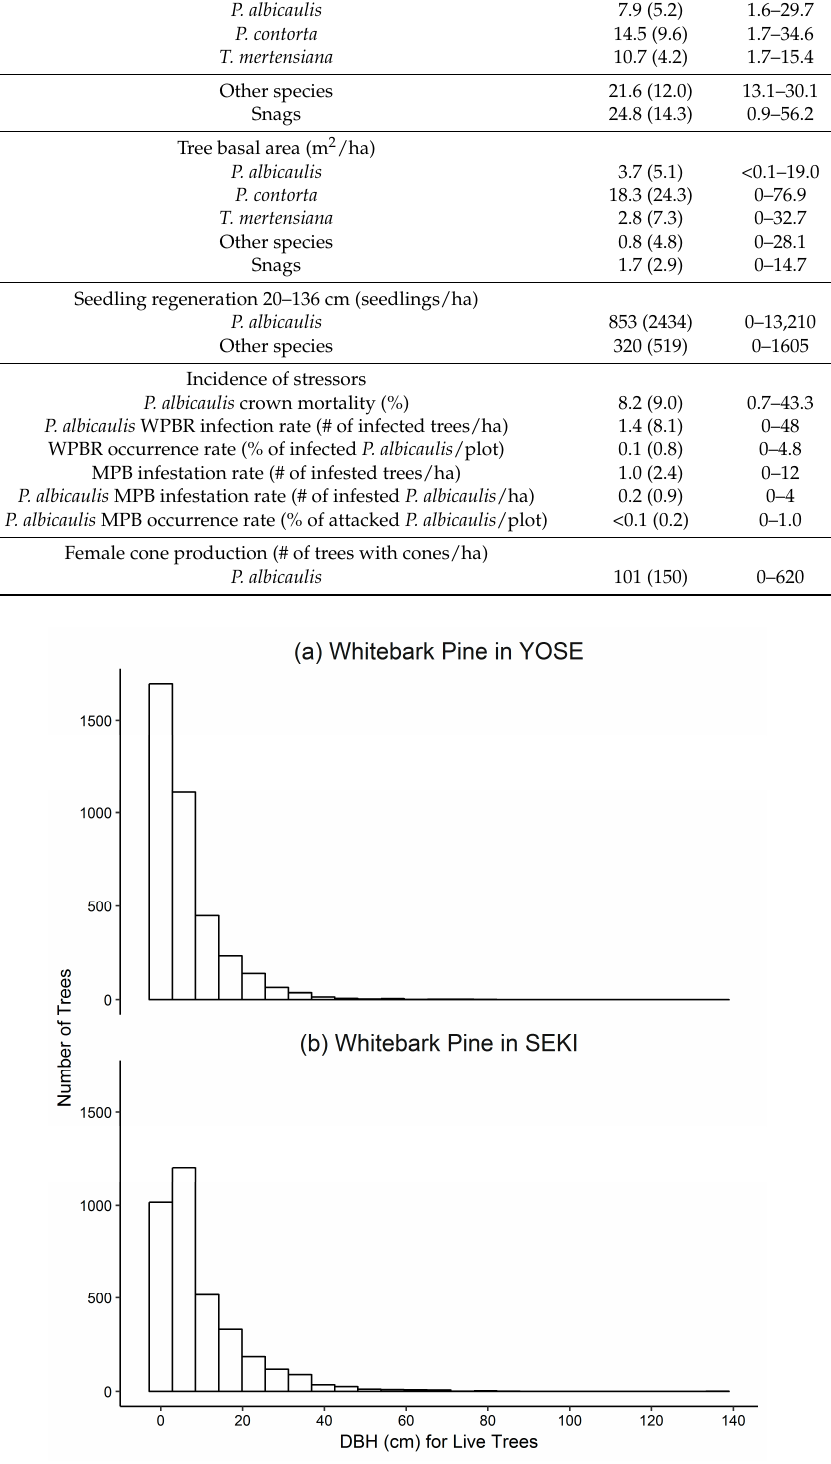
Figure 8. Histogram of all live whitebark pine diameter at 1.37 m (DBH) in Yosemite National Park (YOSE), CA, USA ( a ) and Sequoia and Kings Canyon National Parks (SEKI), CA, USA ( b ). DBH ranged from 0.4 to 78.3 cm in YOSE and 0.4 to 136.5 in